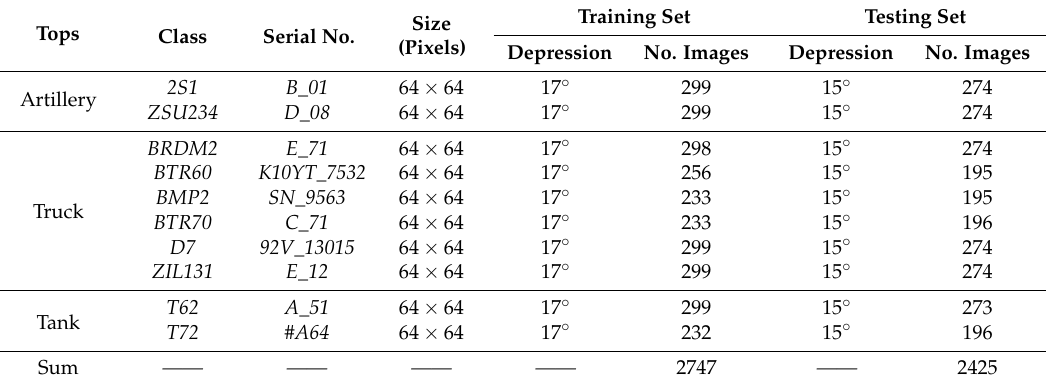
Table 1. Detailed information of the MSRAT dataset used in our experiments.